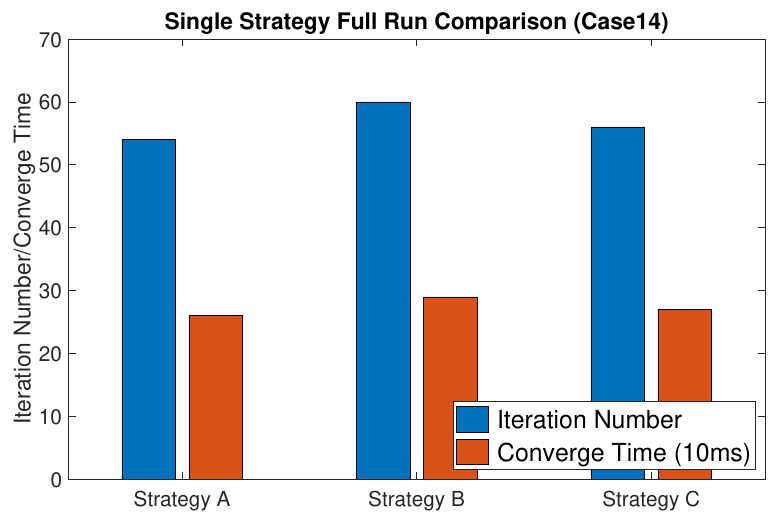
Figure 3. Single strategy full run comparison. Using only one strategy until convergence. The blue bar is the number of iterations for each strategy, and the red bar is the convergence time in 10 ms.